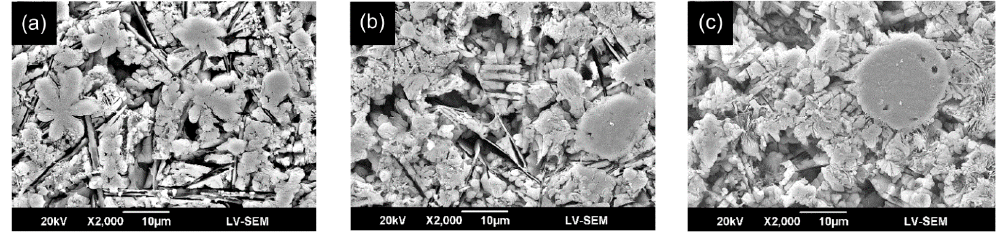
Figure 7. SEM metallographs of mid-section region of cross sectional CL in FA/ZrO 2 laser-clad specimens: ( a ) 400 W, 200 mm/min; ( b ) 800 W, 400 mm/min; and ( c ) 1200 W, 600 mm/min.